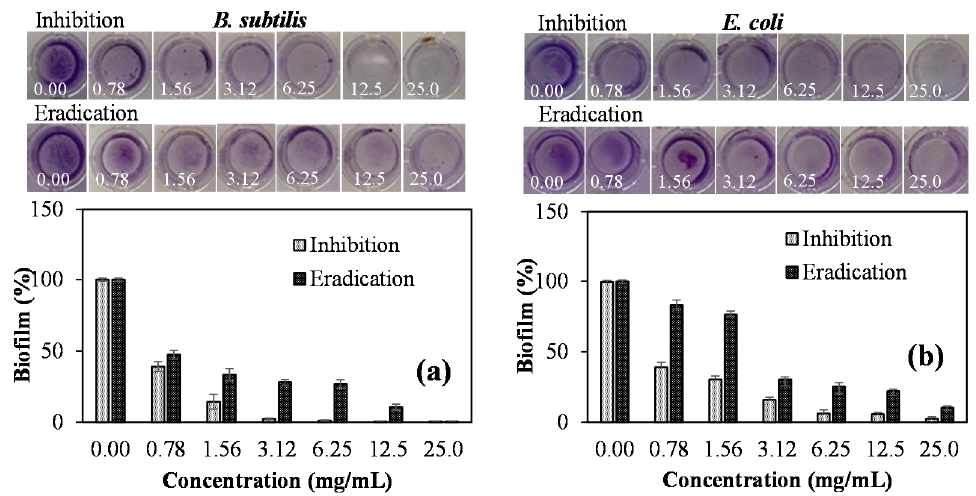
Figure 7. The photographs and inhibition and eradication% of biofilms generated by ( a ) B. subtilis and ( b ) E. coli treated with by N-doped C-dots prepared by CA:PVAm at 1:3 weight ratio using crystal violet assay.